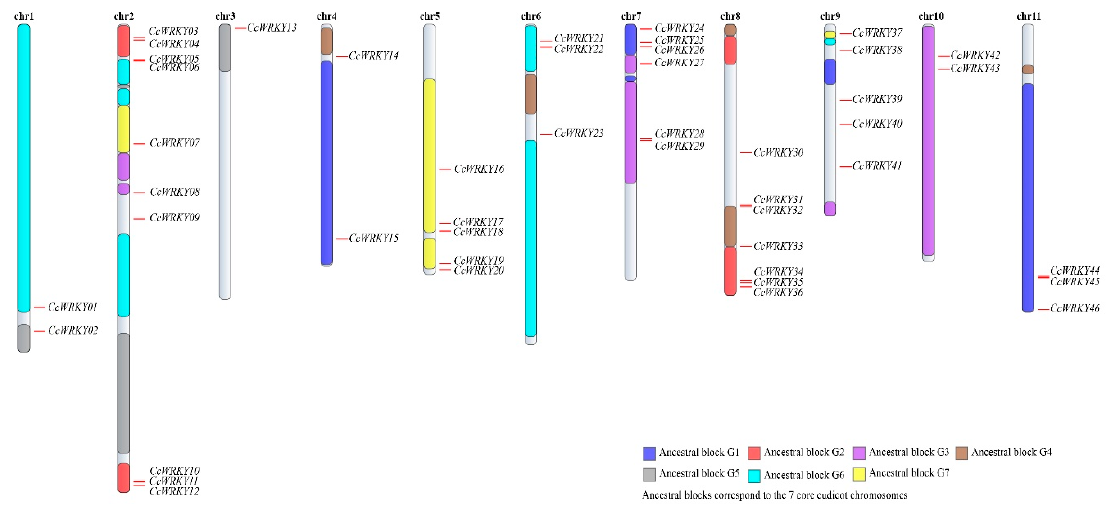
Figure 2. Chromosomal location of 49 CcWRYKs . CcWRKY47–49 ( Cc00_g06830 , Cc00_g13890 , Cc00_g21560 ) were putatively located on ‘Chromosome Unknown’. The chromosomal structure and gene locations were obtained from the Coffee Genome Hub (http://coffee-genome.org/) [33].